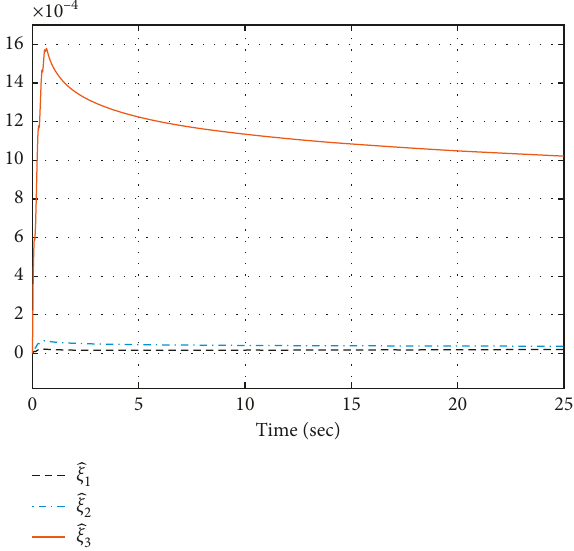
Figure 5: Evolution of the estimation of